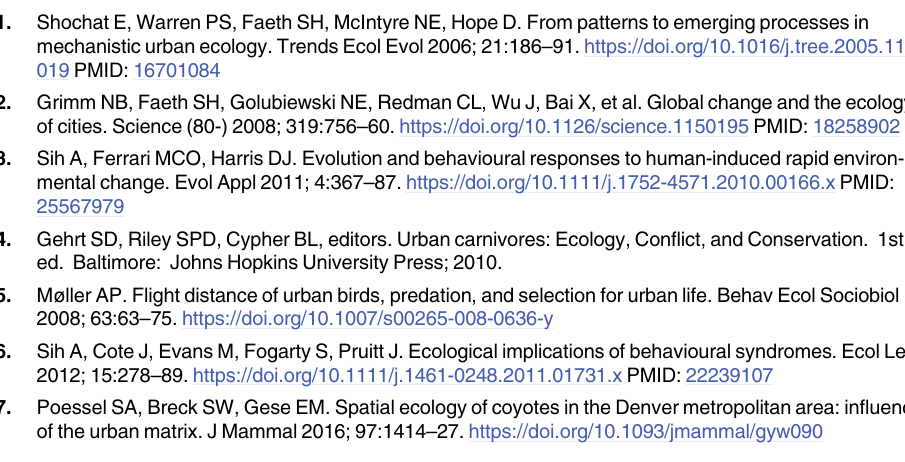
S3 Table. Land use in the coyote vibrissa buffer zones. Land use and human development characteristics in 29 urban, 21 suburban, and 7 rural coyote buffer zones. Spatial analysis